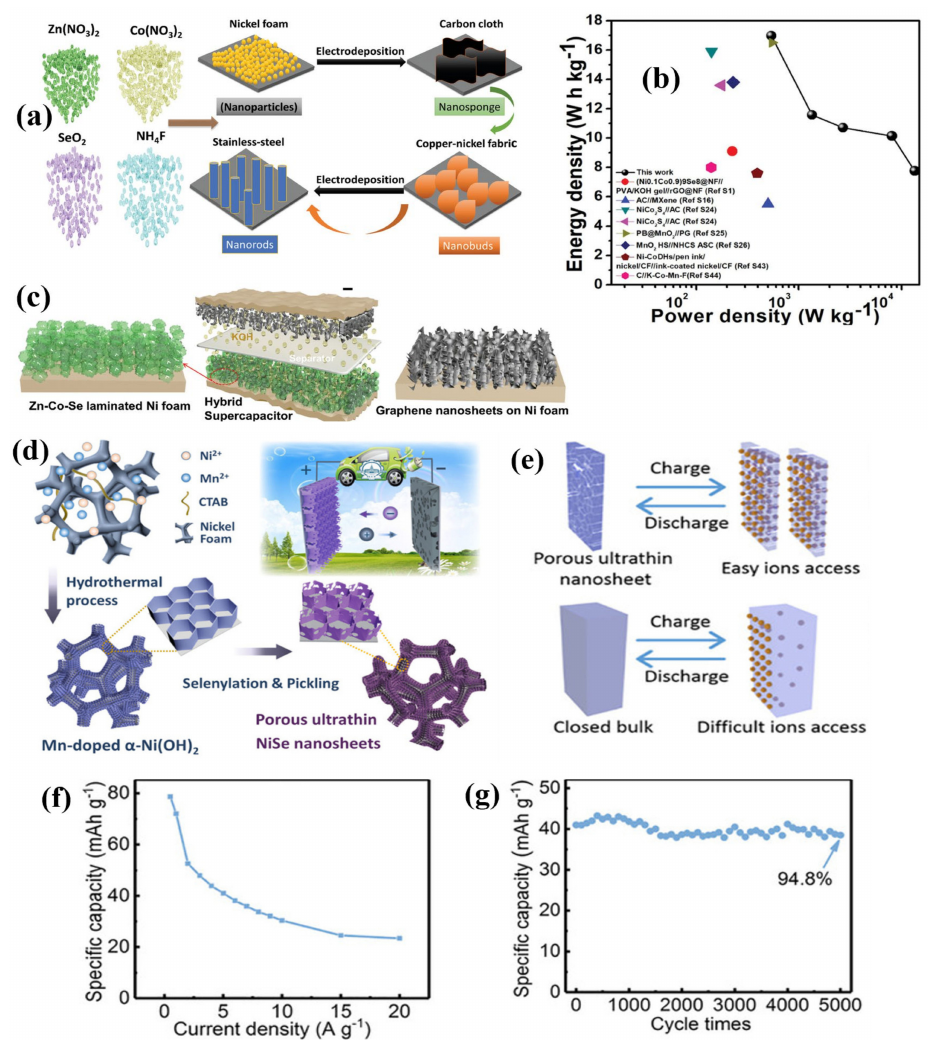
Figure 19. ( a ) Schematic preparation of Zn–Co–Se and Zn–Mn–Se. ( b ) Energy and power density comparison of FAHSC with previous works. ( c ) Schematic illustration of the FAHSC. Adapted with permission [361]. Copyright (2019) John Wiley and Sons. ( d ) Schematics of the fabrication process and application of the porous ultrathin NiSe NNs. ( e ) Schematics of the charge/discharge mechanism, ( f ) Specific capacitance vs. current density, ( g ) Cycle stability of the put-NiSe NNs//PC HSC. Adapted with permission [363]. Copyright (2019) John Wiley and